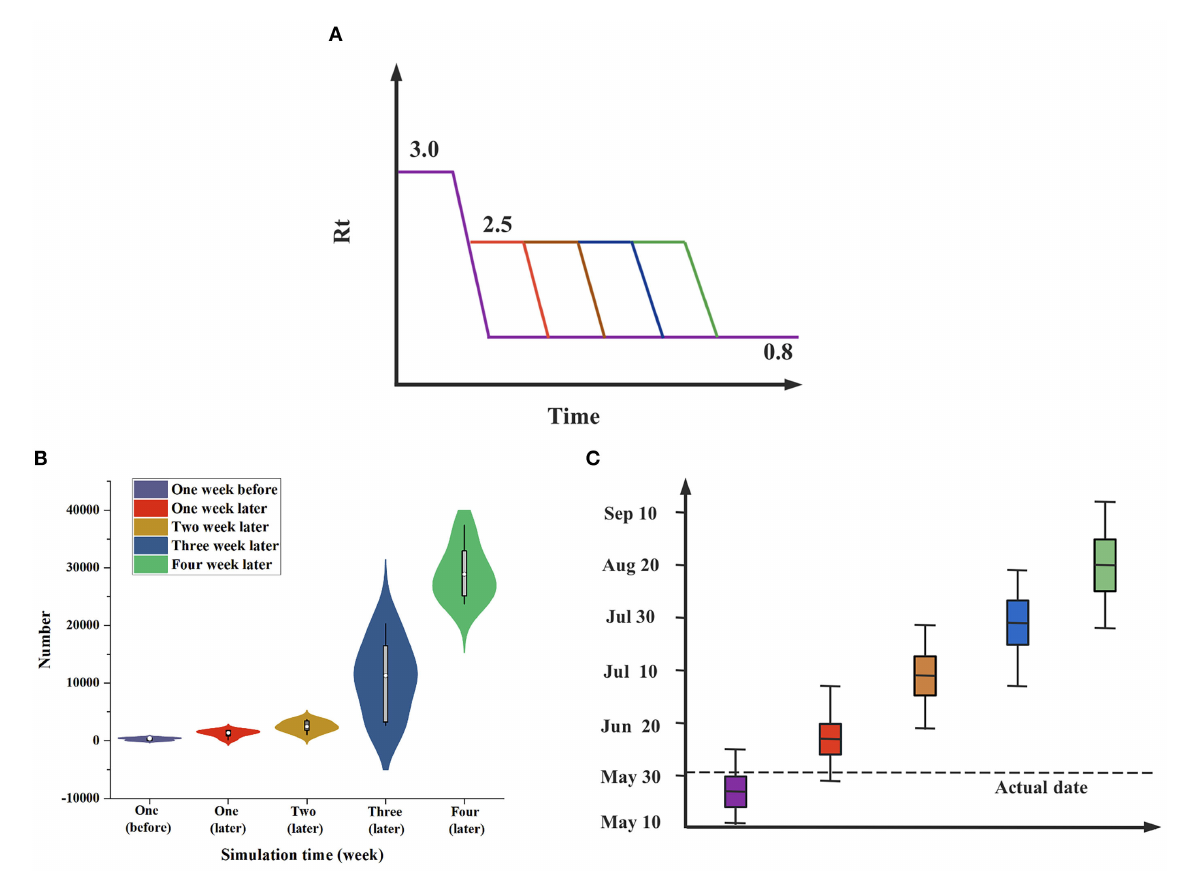
FIGURE3 R t -based simulation prediction. (A) R t is assumed to decline linearly over a 1-week period from R 0 to R final . Estimates in advance simulations are obtained by considering R 0 = 3.0 and R final = 0.8; estimates in deferred simulations are obtained by considering R 0 = 2.5 and R final = 0.8. (B) Differences in the number of cases (when compared to actual values) when public health interventions were implemented 1 week earlier or 1–4 weeks later. (C) The case end date if public health interventions began 1 week earlier or 1–4 weeks